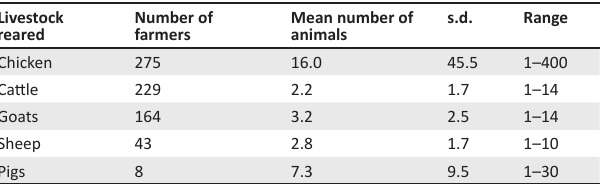
TABLE 3: Livestock reared by farmers within the study sites. Livestock Number of reared